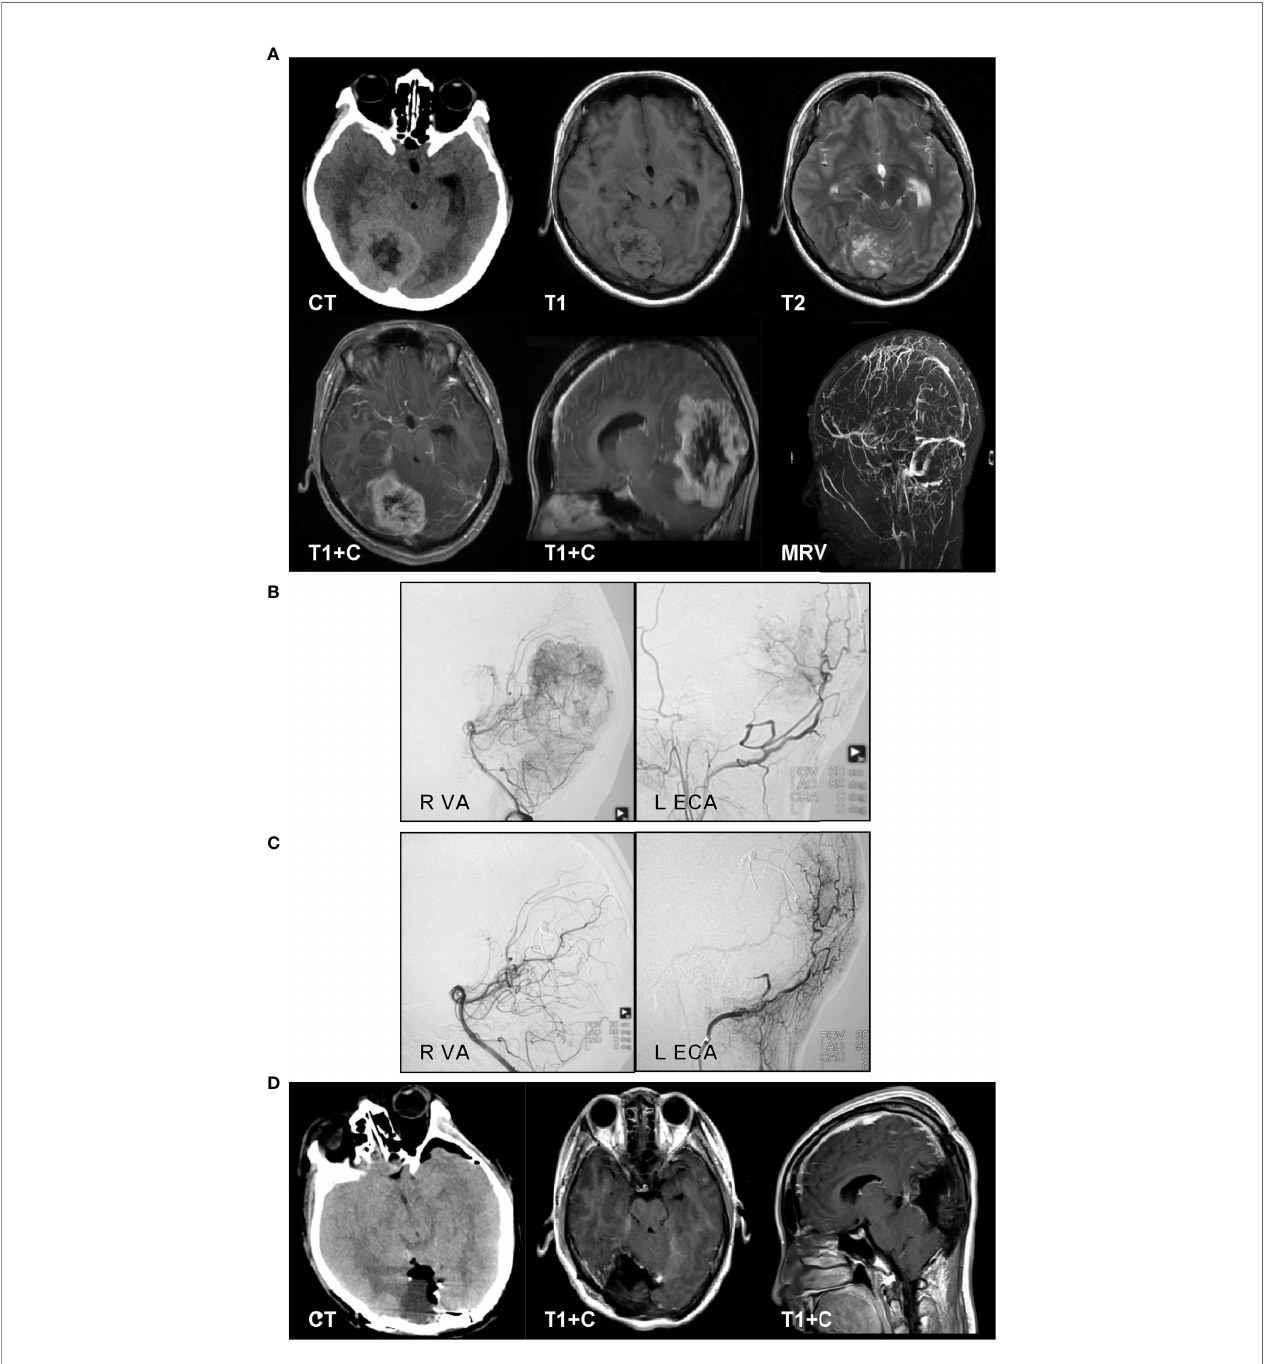
FIGURE 3 | A 33-year-old man complained of headache for 2 months. The CT results revealed a mixed-density, right occipital lesion. The MRI results revealed a right occipital, mixed-signal lesion and fl ow voids on T1- and T2-weighted imaging. The lesion showed obvious enhancement on contrast-enhanced MRI. The magnetic resonance venography results showed an obstructed sagittal sinus (A) . We performed the operation in a hybrid operating room. The cerebral digital subtraction angiography (DSA) results revealed abundant tumor blood. The feeding arteries were the right posterior cerebral artery (PCA), right external carotid artery (ECA), right meningiohypophyseal trunk, and left ECA (B) . Onyx-18 was used for feeding artery embolization for the right PCA, right occipital artery, and left occipital artery. The DSA reexamination results showed that 90% of the blood supply was embolized (C) . Craniotomy was then performed. The occipital interhemispheric transtentorial approach was used to reach the tumor under navigation. The tumor was tenacious, with partial calci fi cation. Piecemeal removal was performed, and we achieved a Simpson grade II resection. The postoperative CT results showed no hemorrhage or infarction (D) . The pathology examination results revealed that the tumor was a